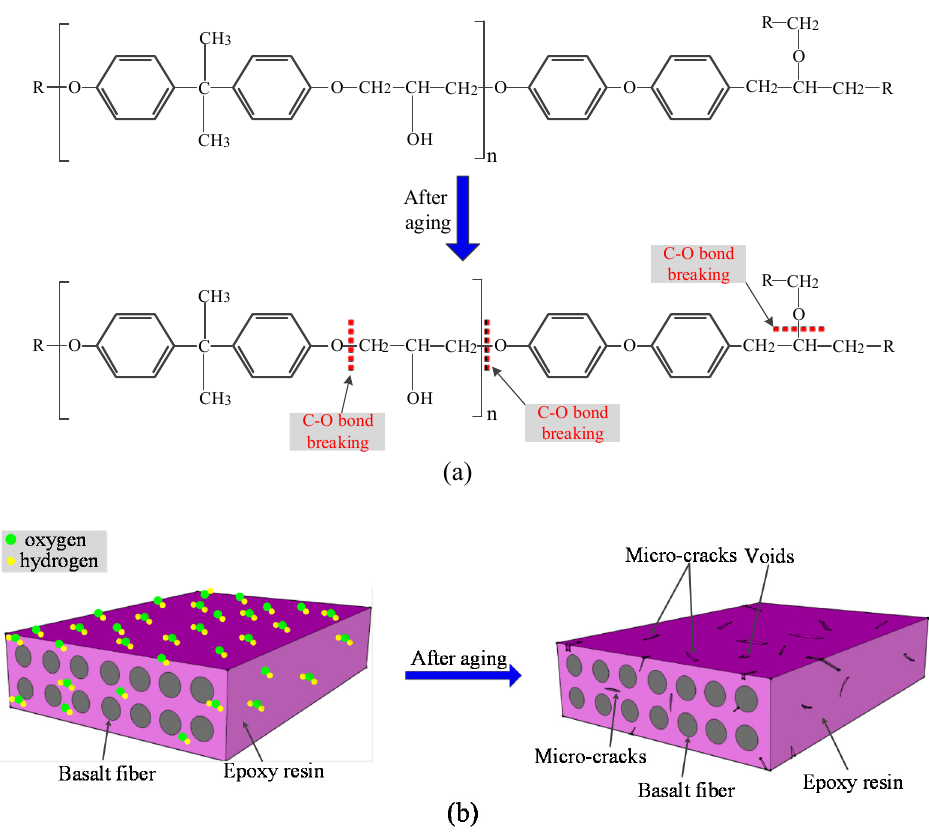
Figure 4. Degradation mechanism of epoxy resin in 60 °C deionized water or alkaline solution. ( a ) breaking down of epoxy molecular chains ( b ) ageing damage of epoxy resin in macroscopy.